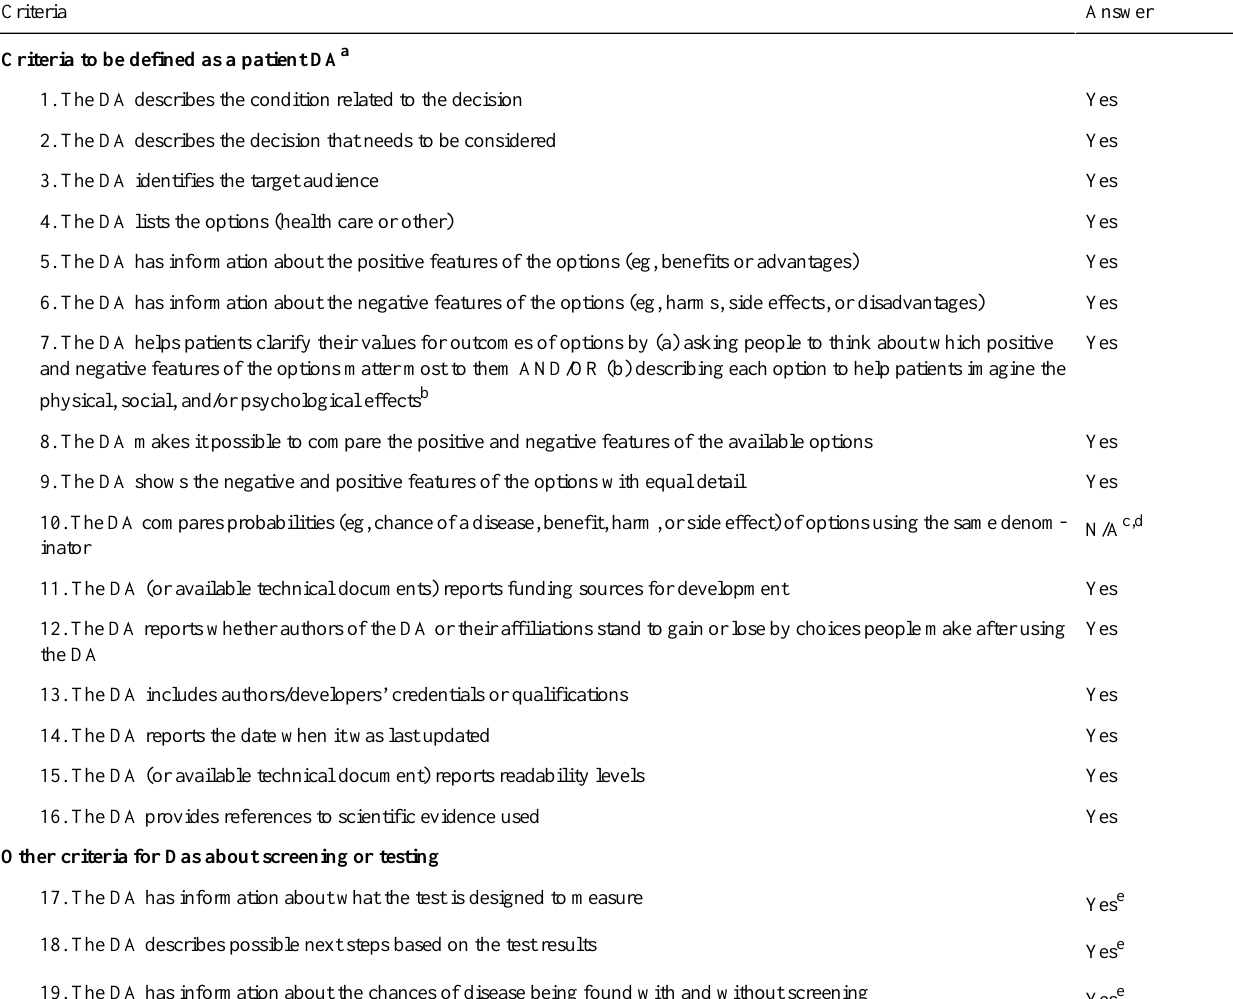
Table 1. Review of the Roadmap to Parenthood patient decision aid using the International Patient Decision Aid Standards quality